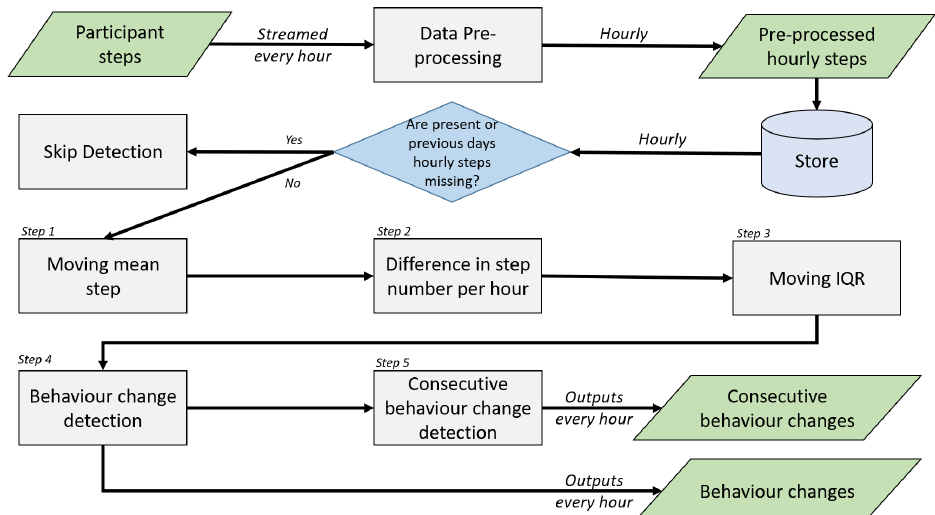
Figure 1. Diagram of U-BEHAVED algorithm